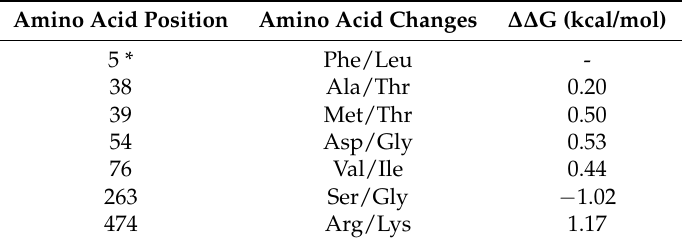
Table 2. In silico calculation of protein stability upon mutation in the structure of L. major